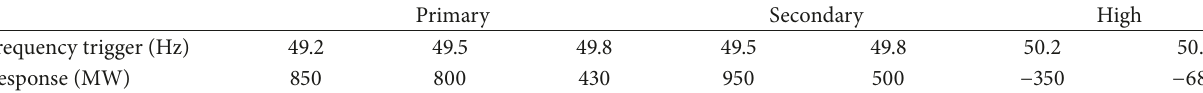
Table 4: Illustrative historic response holding data behind Figure 12.